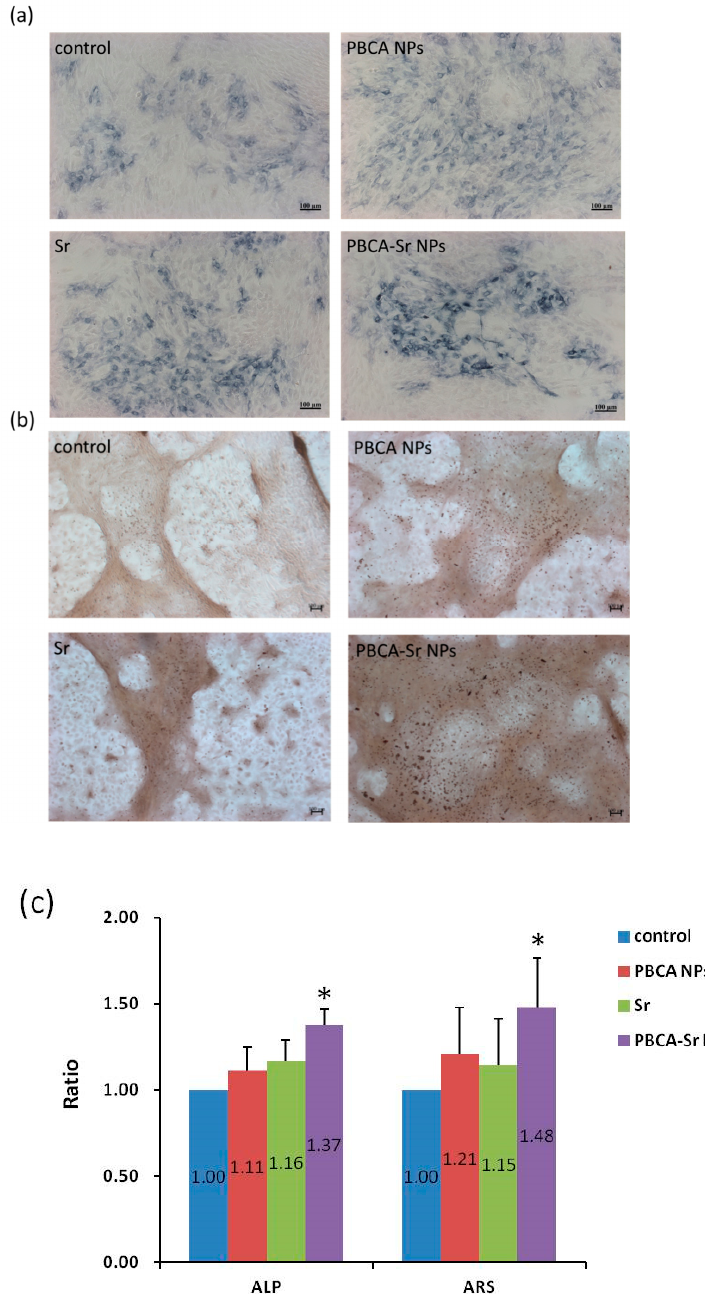
Figure 5. Influence of Sr-NPs on committed MSCs. Committed MSCs was treated with strontium ranelate (0.1 mM), PBCA NPs (50 µ g/mL) or PBCA-Sr NPs (50 µ g/mL containing 0.1 mM Sr). ( a ) Alkaline phosphatase staining following exposure medium for 7 days. ( b ) Alizarin Red S staining was performed at 21 days after treatment. Scale bar = 100 µ m. ( c ) Quantification of ALP and ARS as a ratio to control. * p <